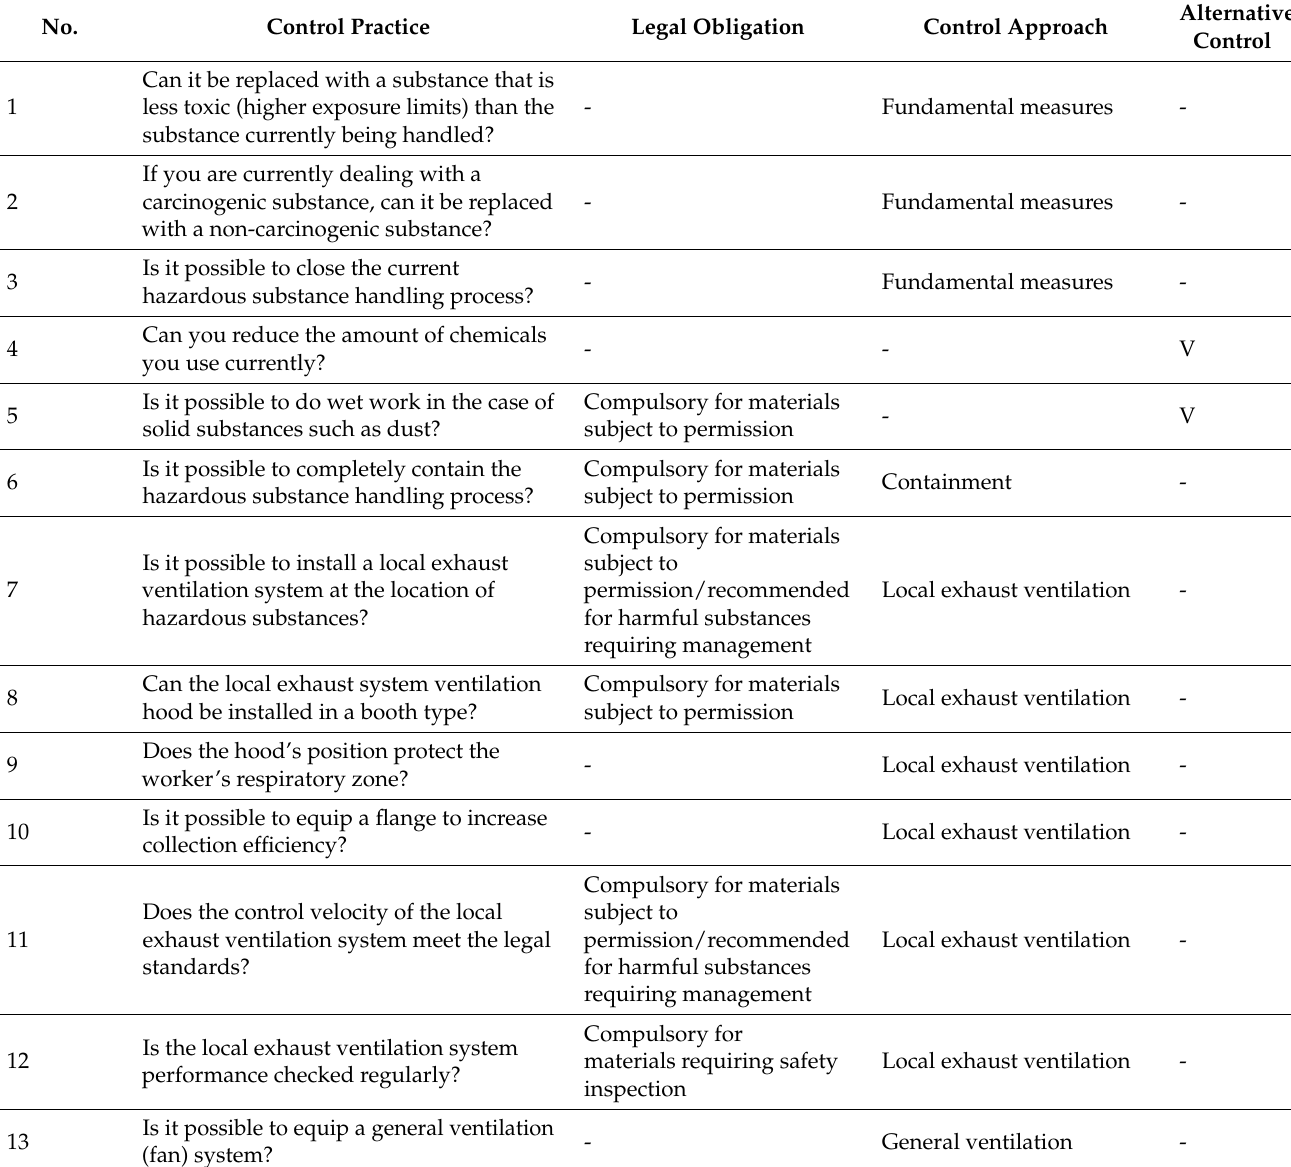
Table 8. Classification of items in the control status checklist of Chemical Hazard Risk Management (CHARM) for working